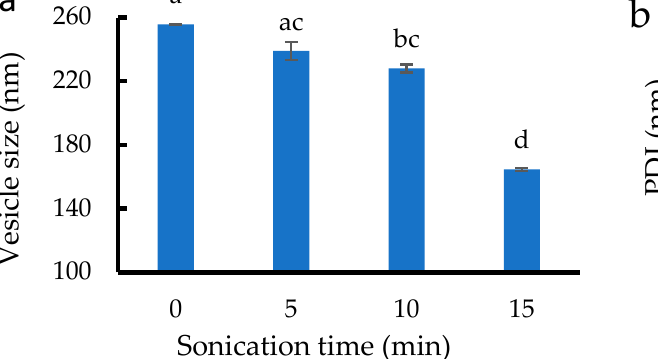
Figure 1. ( a ) Vesicle size, ( b ) size distribution, and ( c ) zeta potential of different formulations of blank ethosomes. Different letters above the error bars indicate significant differences at the 0.05 level (ANOVA and post hoc test).